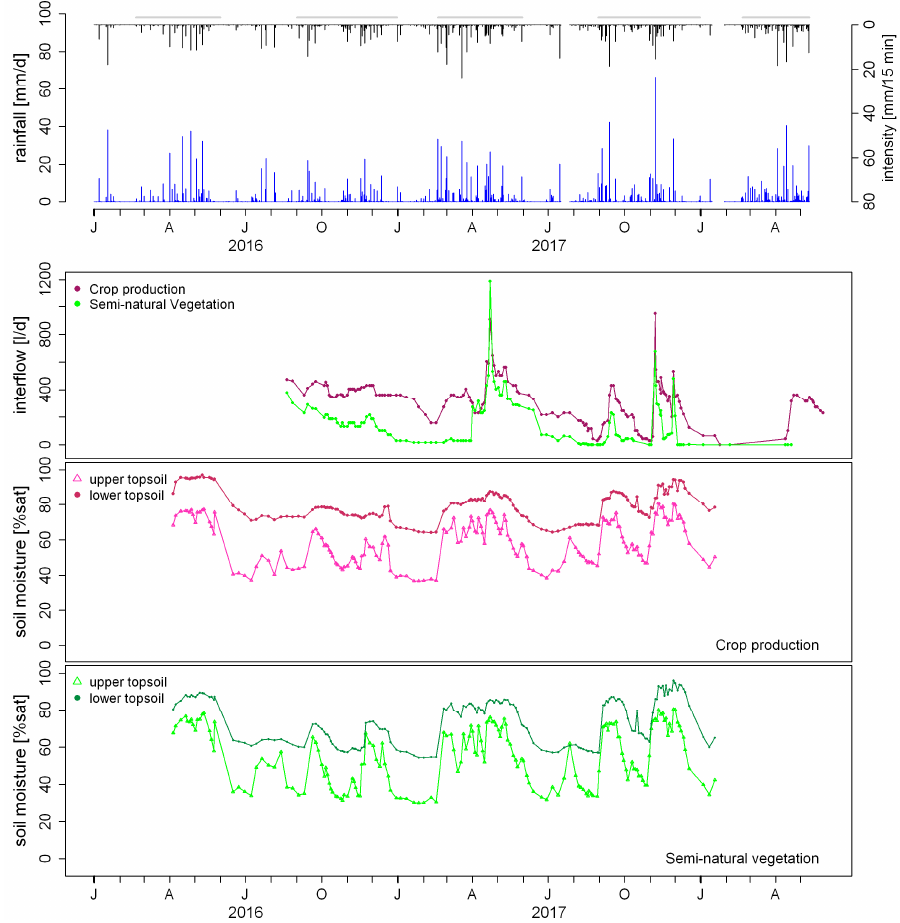
Figure 5. Interflow at the plot under crop production and the plot under semi-natural vegetation during the investigation period (second panel), related to daily rainfall and max. 15 min. rainfall intensity (blue and black bars in the first panel) and soil moisture dynamics [% sat] at 0–20 cm and 20–40 cm depth under crop production (third panel) and under semi-natural vegetation (fourth panel). Grey bars indicate the duration of the rainy seasons. Timeline labeling “J A J O” refers to January, April, July, October. Nitrate concentrations in the interflow were significantly different between the three land-use types during the rainy but also during the dry season, which again stresses the presence of a strong delayed interflow component. Nevertheless, concentrations were lower and more similar between the three land-use types during the dry season (see Fig- ure 5). Hence, it can be assumed that the interflow water of the delayed interflow compo- nent mixes over bigger areas. The event-based measurement (see Table 3) revealed an increase in interflow vol- umes of 31% at the plot under crop production and 17 % at the plot under semi-natural vegetation directly after the rainfall event. This fits the high interflow volumes measured